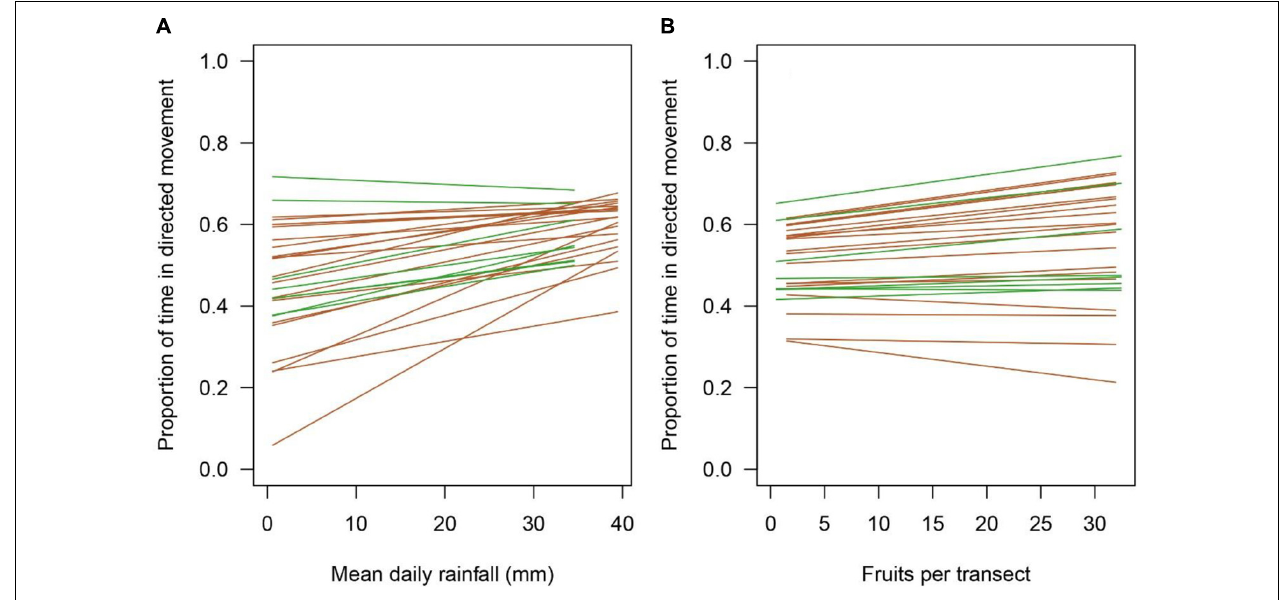
FIGURE 6 | Individual-level relationship between directed movement and rainfall (A) and fruit abundance (B) at monthly scales. Where: lines = individual-level proportion of time in directed movement in relation to rainfall (A) and fruit abundance (B) ; green = elephants in Ivindo; brown = elephants in Wonga